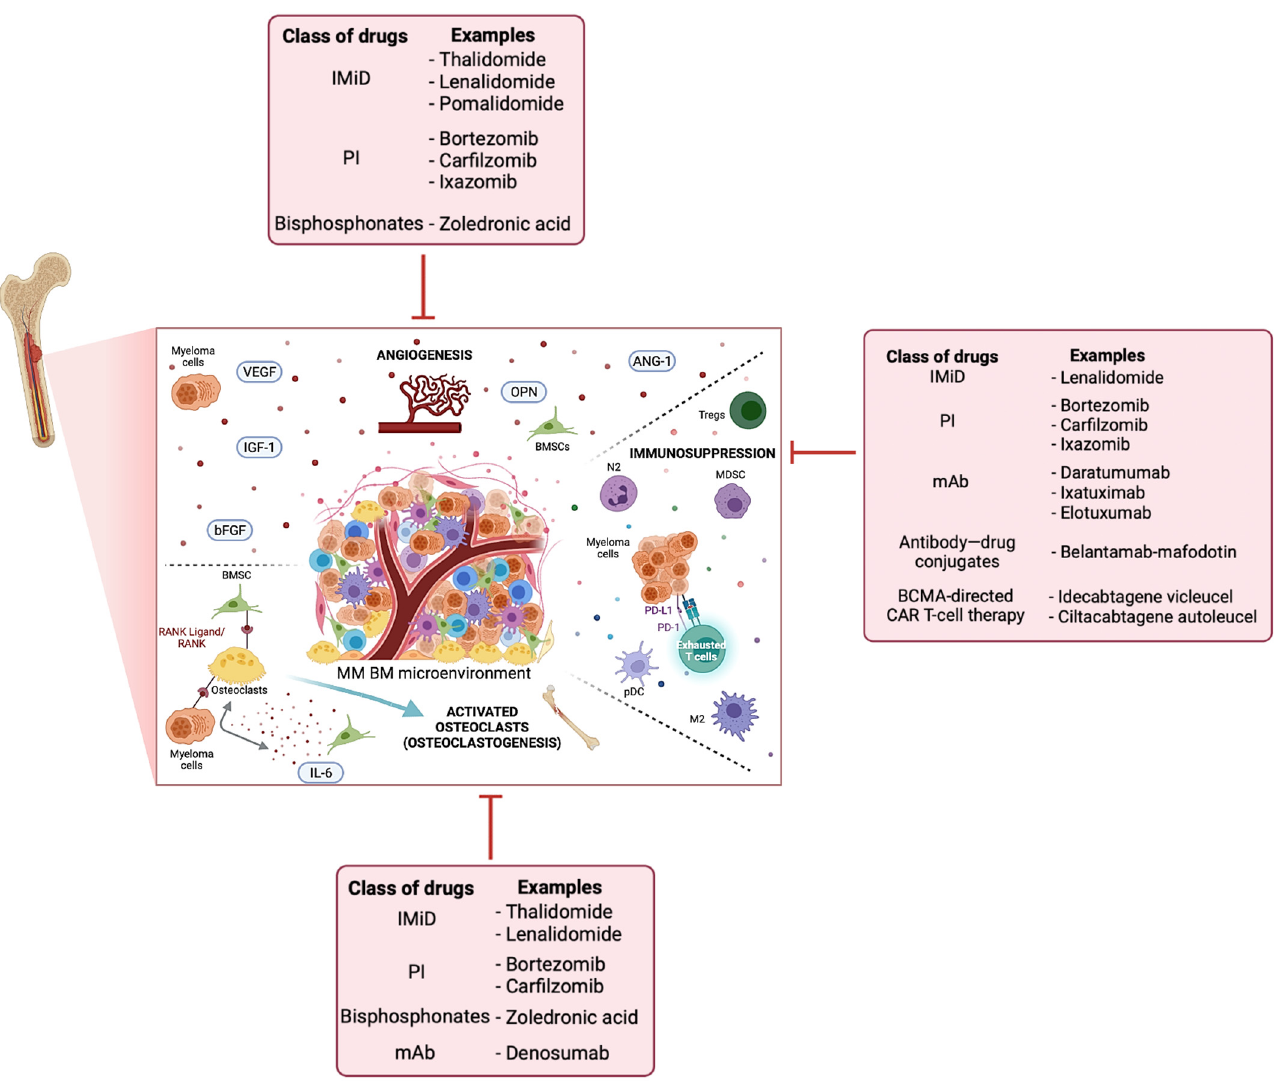
Figure 1. Alterations found in the MM BM niche and therapeutic options to counteract MM. The central box recapitulates the main dysfunctions of the BM microenvironment upon MM establish- ment, namely angiogenesis, immunosuppression and osteoclastogenesis (separated by dotted lines). The pink boxes summarize the action of different classes of approved drugs used to inhibit dysreg- ulated pathways in the BM microenvironment or to induce a cytotoxic immune response against myeloma cells. Created with BioRender.com. Abbreviations: Ang-1, angiopoietin-1; BCMA, B-cell maturation antigen; bFGF, basic fibroblast growth factor; BMSC, bone marrow stromal cells; CAR, chimeric antigen receptor; IGF-1, type-1 insulin-like growth factor; IL-6, interleukin 6; IMiD, immuno- modulators; M2, macrophages type 2; mAb, monoclonal antibodies; MDSC, myeloid-derived suppres- sor cells; N2, neutrophils type 2; OPN, osteopontin; PD-1, programmed death; pDC, plasmacytoid dendritic cells; PD-L1, programmed death-ligand 1; PIs, proteasome inhibitors; RANK, receptor activator of NF- κ B; Treg, regulatory T cells; VEGF, vascular endothelial growth factor. The inhibition of osteoblast function and the activation of bone-resorbing osteoclasts are also found in the MM BM milieu [32,33]. This imbalance can be mediated directly by myeloma cells via the receptor activator of NF- κ B ligand (RANKL), hepatocyte growth factor (HGF) or interleukin (IL)-3, or indirectly via BMSC through the upregulation of RANKL and secretion of IL-6, IL-1 β or tumor necrosis factor (TNF)- α [34]. While PIs such as bortezomib have shown to both inhibit osteoclast differentiation and stimulate osteoblast formation